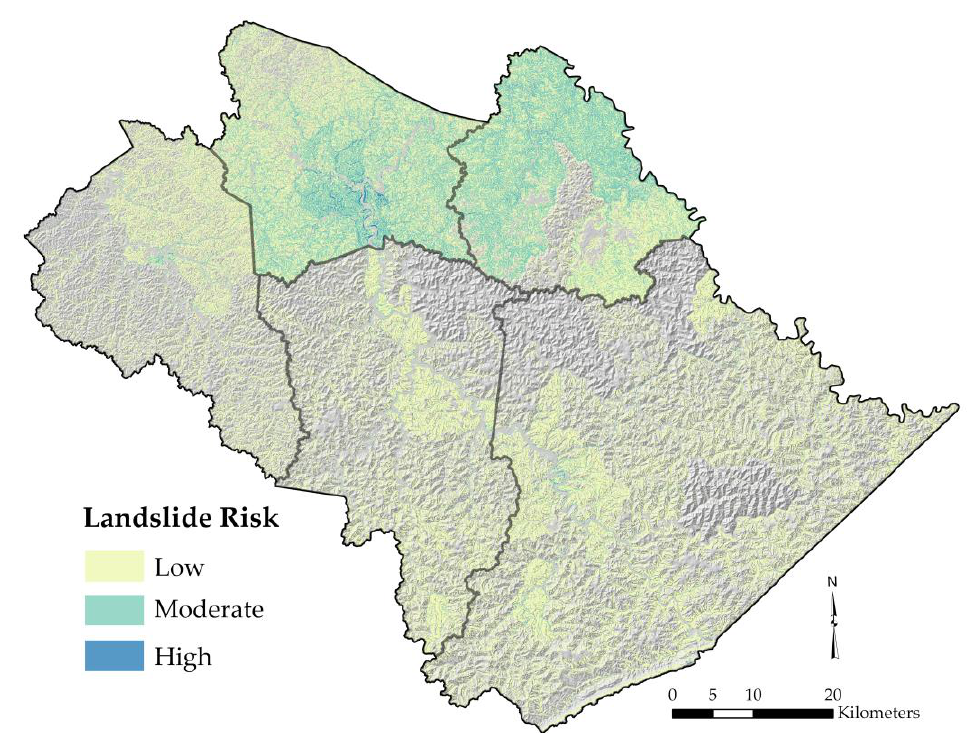
Figure 12. Slope-based risk map of the Big Sandy Area Development District. A coarse slope map as the hazard input and population data generated from U.S. Census block groups models an inconsistent risk distribution, creating stark boundaries of risk classes. Counties models were generated individually, those with smaller population ranges show high-skewing results. County boundaries are shown in